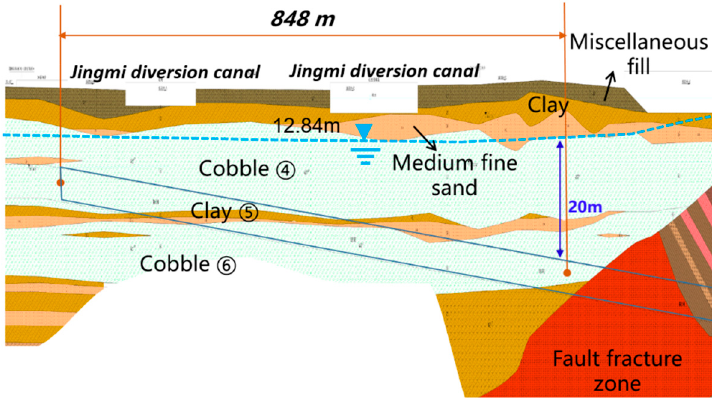
Figure 2. Involved soils of the tunnel construction at the Beijing south-to-north water diversion auxiliary project.